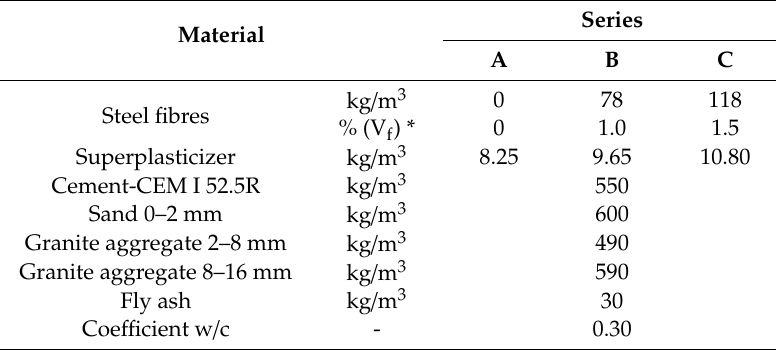
Table 2. Concrete mixture